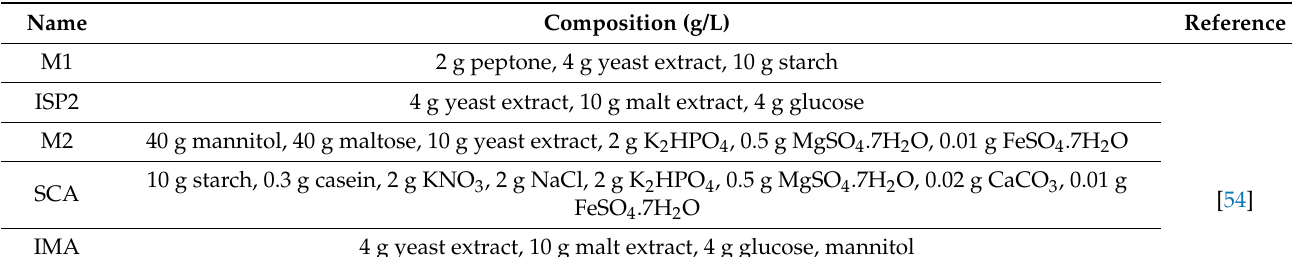
Table 2. Composition of culture